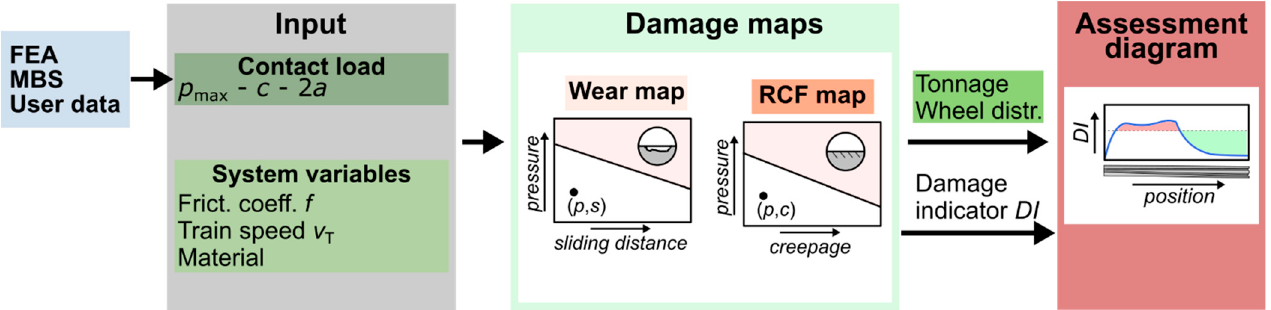
Figure 2. Calculation procedure of the simplified damage assessment tool to assess wear and RCF with standard models on the local contact-patch level based on load data from FEA, MBS or manual input by the user and loading statistics (tonnage and wheel distribution).